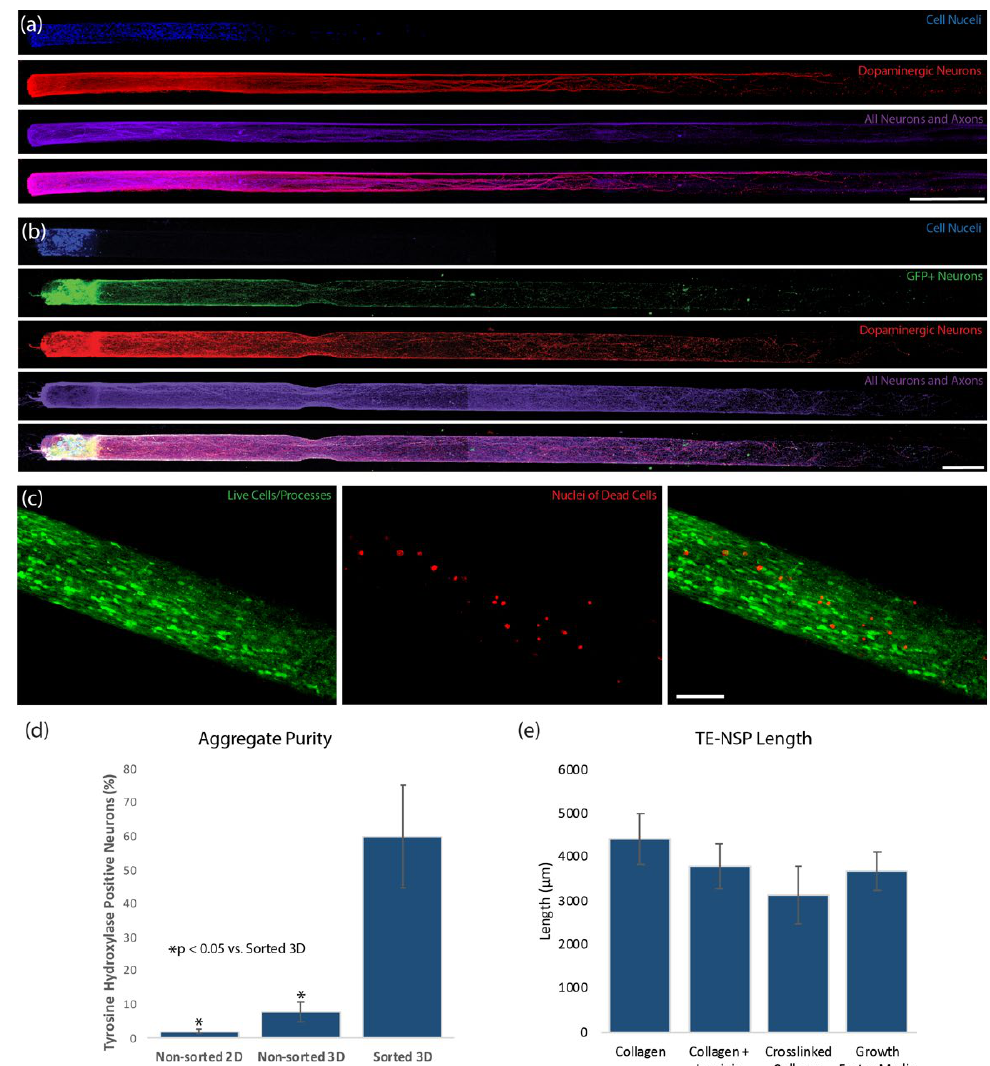
Figure 2. Optimization of Enriched TE-NSPs. ( a , b ) Confocal reconstructions of representative constructs at 14 DIV labeled via immunocytochemistry to denote all neurons/axons (β -tubulin III, purple) and dopaminergic neurons/axons (TH, red), with nuclear counterstain (Hoechst, blue). Both constructs demonstrated the desired cytoarchitecture consisting of discrete cell bodies and axonal regions. ( a ) A construct generated with neurons isolated from the ventral mesencephalon absent in any enrichment process. ( b ) A construct containing a neuronal population that was enriched for GFP+ dopaminergic neurons using FACS. ( c ) Viability assay on enriched TE-NSPs showing live cells/processes (green) and the nuclei of dead cells (red). ( d ) TE-NSPs generated using FACS- enriched aggregates (“Sorted 3D”) demonstrated a higher percentage of dopaminergic neurons in comparison to TE-NSPs plated with aggregates (“Non-sorted 3D”) or planar cultures (“Non-sorted 2D”) made from the standard midbrain isolation at 14 DIV (n = 5 TE-NSPs each group; Mann– Whitney test, p < 0.05). ( e ) One-way ANOVA ( p = 0.3297) determined that all ECM cores and high growth factor media resulted in statistically equivalent TE-NSP length at 14 DIV (n = 6 TE-NSPs per group). Data presented as mean ± standard deviation. Scale bar ( a ) = 500 µm. Scale bar ( b ) = 250 µm. We next tested the effects of various ECM constituents, as well as growth factors, on the axonal outgrowth of the enriched TE-NSPs. While the use of 1 mg/mL rat tail collagen as the inner core produced TE-NSPs with the longest axonal outgrowth at 14 DIV, these results did not differ statistically from those found when laminin was added or when crosslinked collagen was used (Figure 2e). Likewise, the use of media containing high